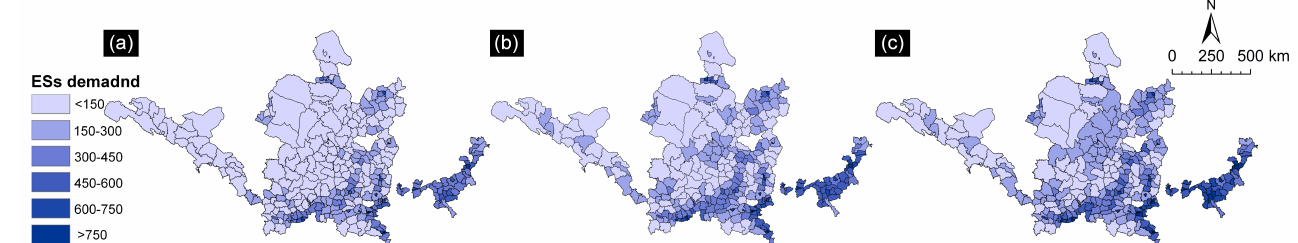
Figure 3. Spatial distribution map of ESs demand in resource-based cities in the YRB from 2000 to